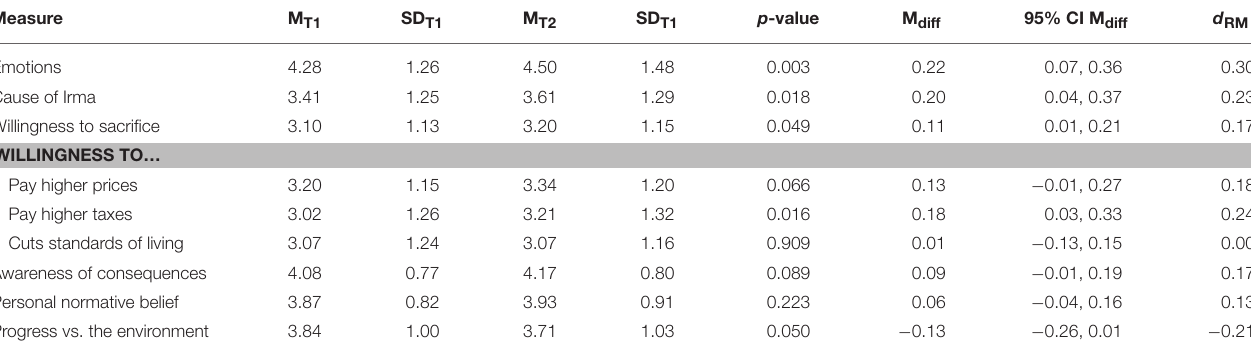
TABLE 1 | Effects of experiencing an extreme weather event presented in means and standard deviations for both pre- and post-measures, and p -values, effect sizes and confidence intervals for change between pre- and post-measures. Measure M T1 SD T1 M